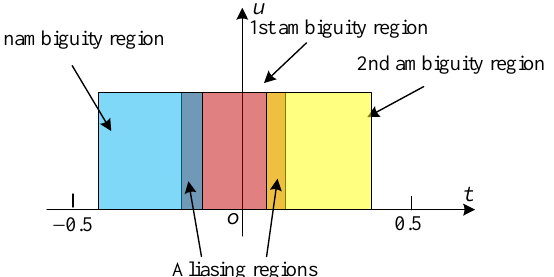
Figure 5. Echo data in the slow-time domain using the proposed method when illumination time is longer than the shifting